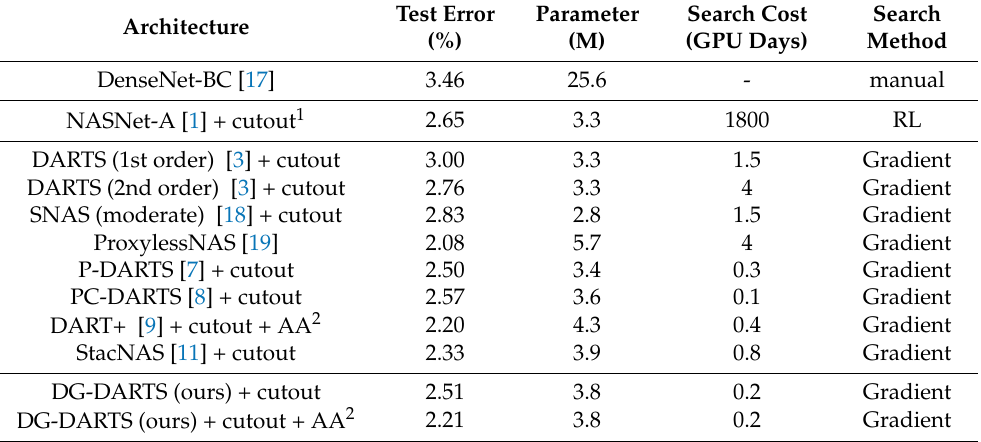
Table 2. Comparison of state-of-the-art architectures with on the CIFAR 10 data set. Architecture